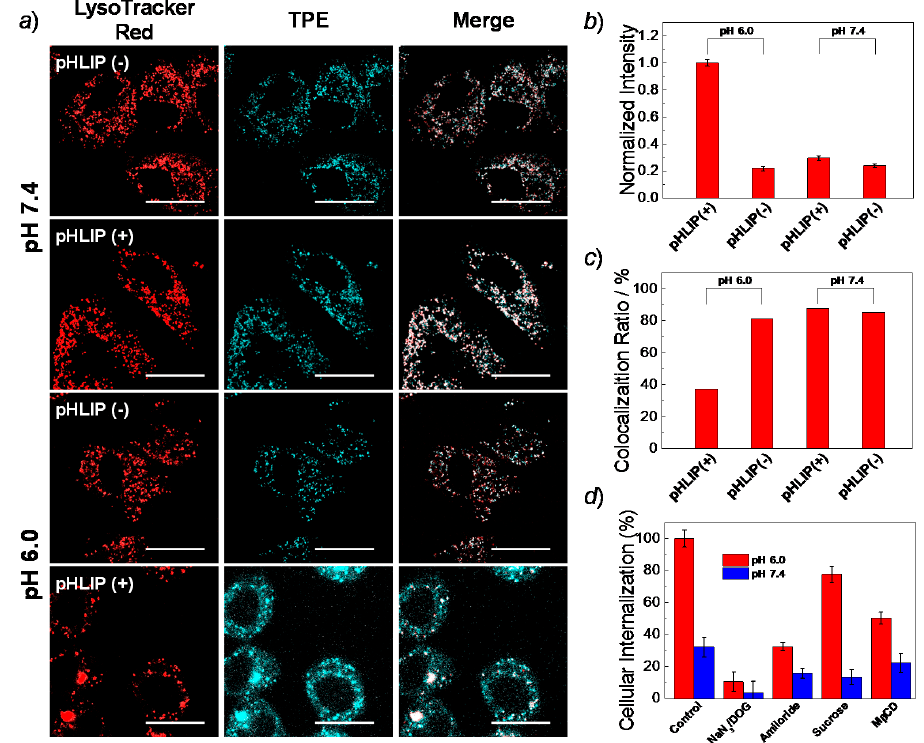
Figure 2. ( a ) Confocal laser scanning images (CLSMs) of A549 cells stained with LysoTracker Red and CCL micelles with or without pHLIP targeting peptide for 2 h at 37 °C. The final concentration of the CCL micelles in the culture medium was 0.05 g/L and the pH of the culture medium was adjusted to 6.0 with NH 4 Cl (scale bar: 50 μ m; TPE (tetrakis[4-(2-mercaptoethoxy)phenyl]ethylene) channel: λ ex = 405 nm, λ em = 475 ± 25 nm; LysoTracker Red: λ ex = 543 nm, λ em = 605 ± 25 nm); ( b ) Normalized TPE fluorescence intensities within A549 cells quantified from CLSM observations; ( c ) Colocalization ratios of cyan fluorescence from CCL micelles and red emission of LysoTracker Red; and ( d ) Probing the mechanisms of cellular internalization using inhibitors of specific endocytic pathways at pH 7.4 and 6.0, respectively.